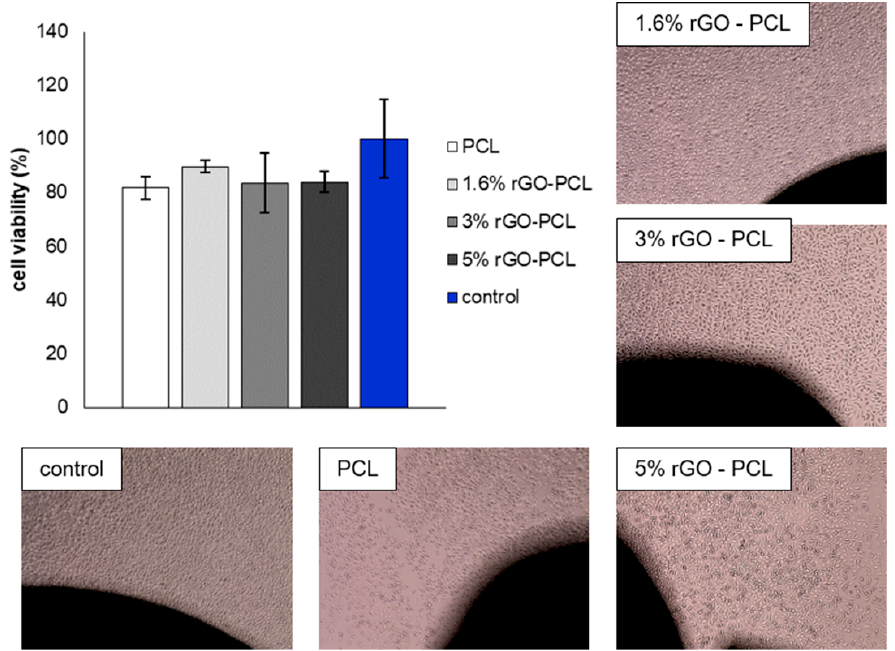
Figure 2. In vitro cytotoxicity evaluation of rGO-PCL compounds. Cell viability percentage of murine fibroblasts (NCTC clone 929) in contact with rGO-PCL compounds for 48 h. Sterile titanium was used as control. Data are expressed as mean ± SD. Multi comparison statistical analyses were performed by using one-way ANOVA. A T test was performed for all pairwise comparisons between group means. Representative images show fibroblasts after 48 h of culture with each sample.